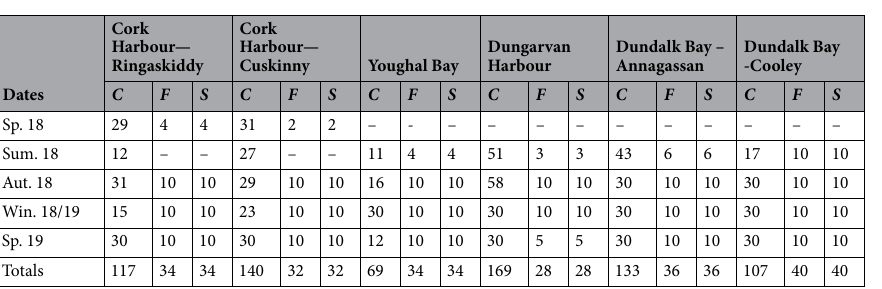
Table 4. Number of collected cockles (C.), bird faecal samples (F.) and sediment samples (S.) by site and season (Sp.18: spring 2018; Sum.18: summer 2018; Aut.18: autumn 2018; Wint.18/19: winter 2018/19; Sp.19: spring 2019). (–) No samples